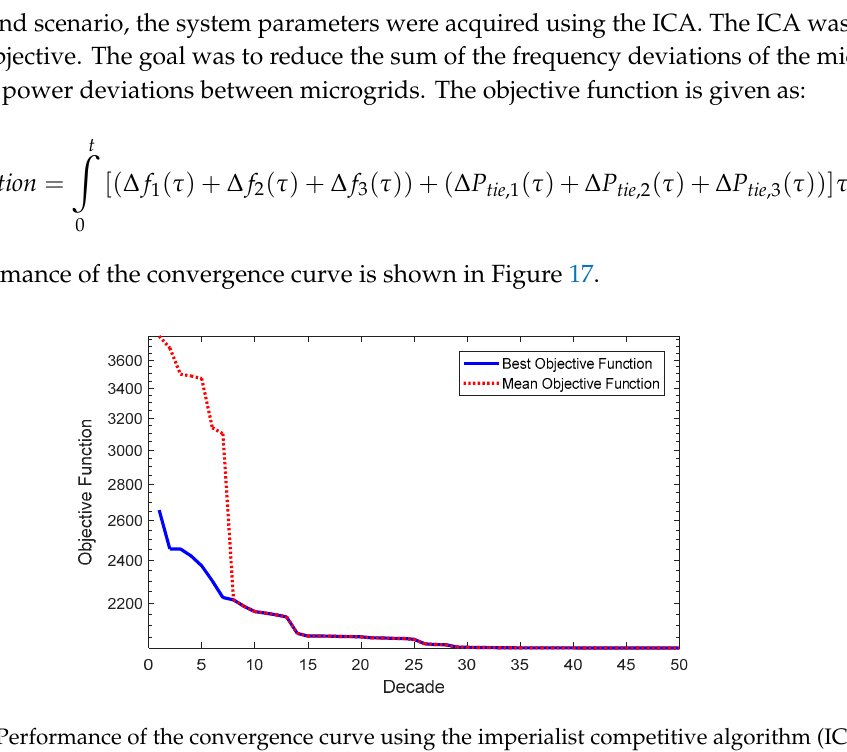
Table 4. Non-optimal control parameter values.